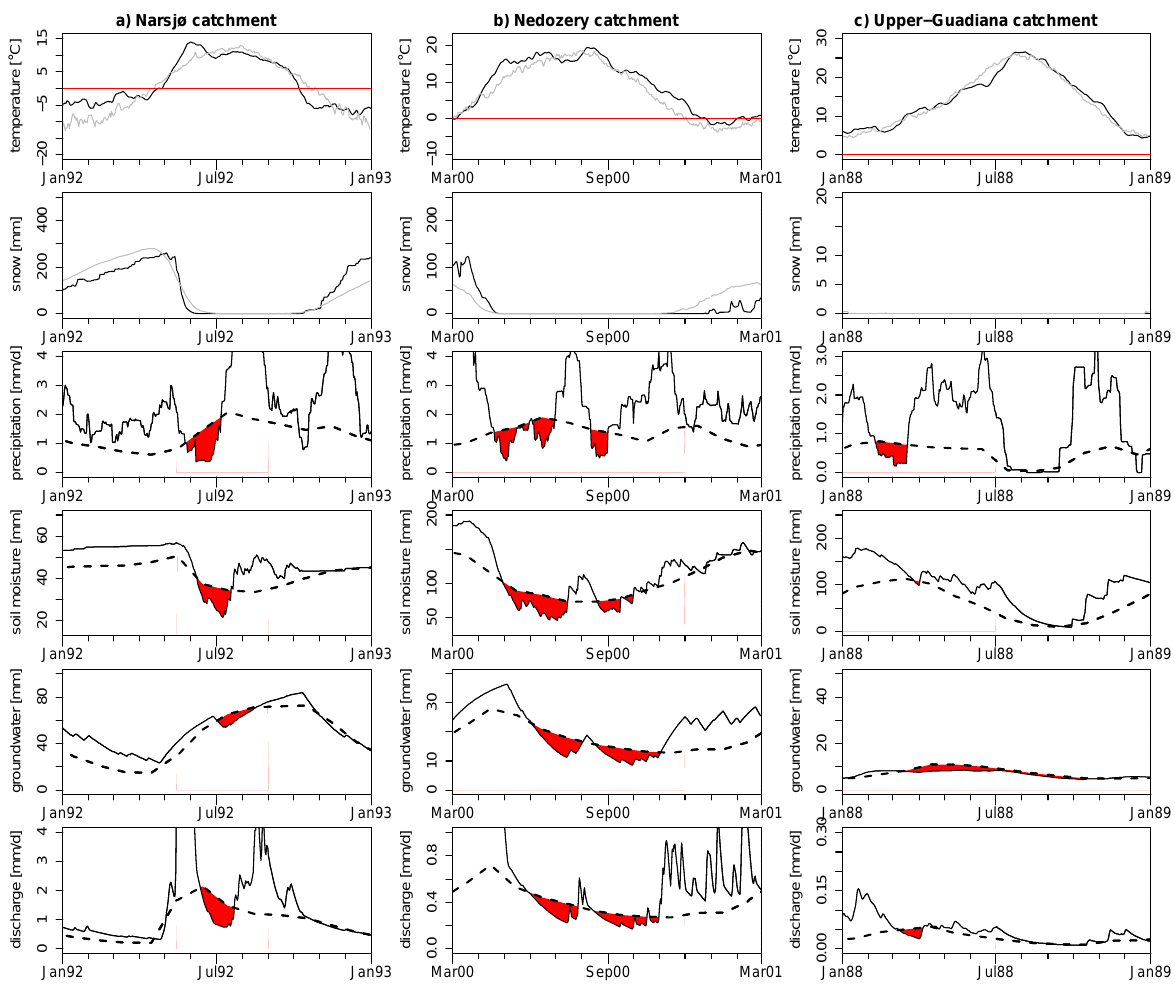
Fig. 5. Examples of classical rainfall deficit drought type: (a) Narsjø catchment 1992–1993, (b) Nedoˇzery catchment 2000–2001, (c) Upper- Guadiana catchment 1988 (all panels: grey line = long-term average of displayed variable, dashed line = smoothed monthly 80%-threshold of displayed variable, red area = drought event referred to in text; upper panel: black line = 30-day moving average of observed temperature, red line = 0 degrees; second panel: black line = simulated snow accumulation; third panel: black line = 30-day moving average of observed precipitation; fourth panel: black line = simulated soil moisture; fifth panel: black line = simulated groundwater storage; lower panel: black line = simulated